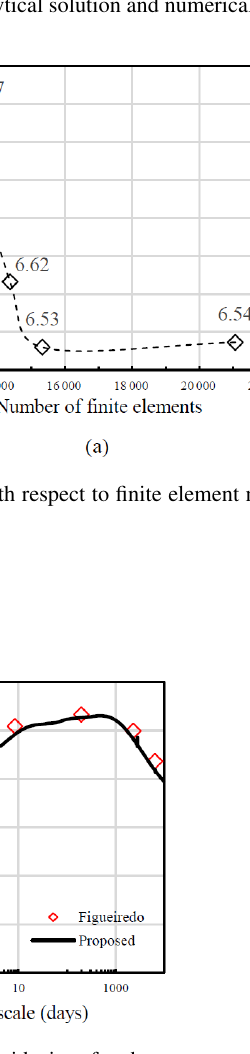
Figure 5. Comparison between analytical solution and numerical simulation.